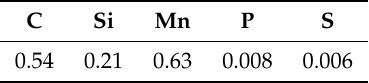
Table 1. Chemical composition of the investigated 0.54% carbon steel.